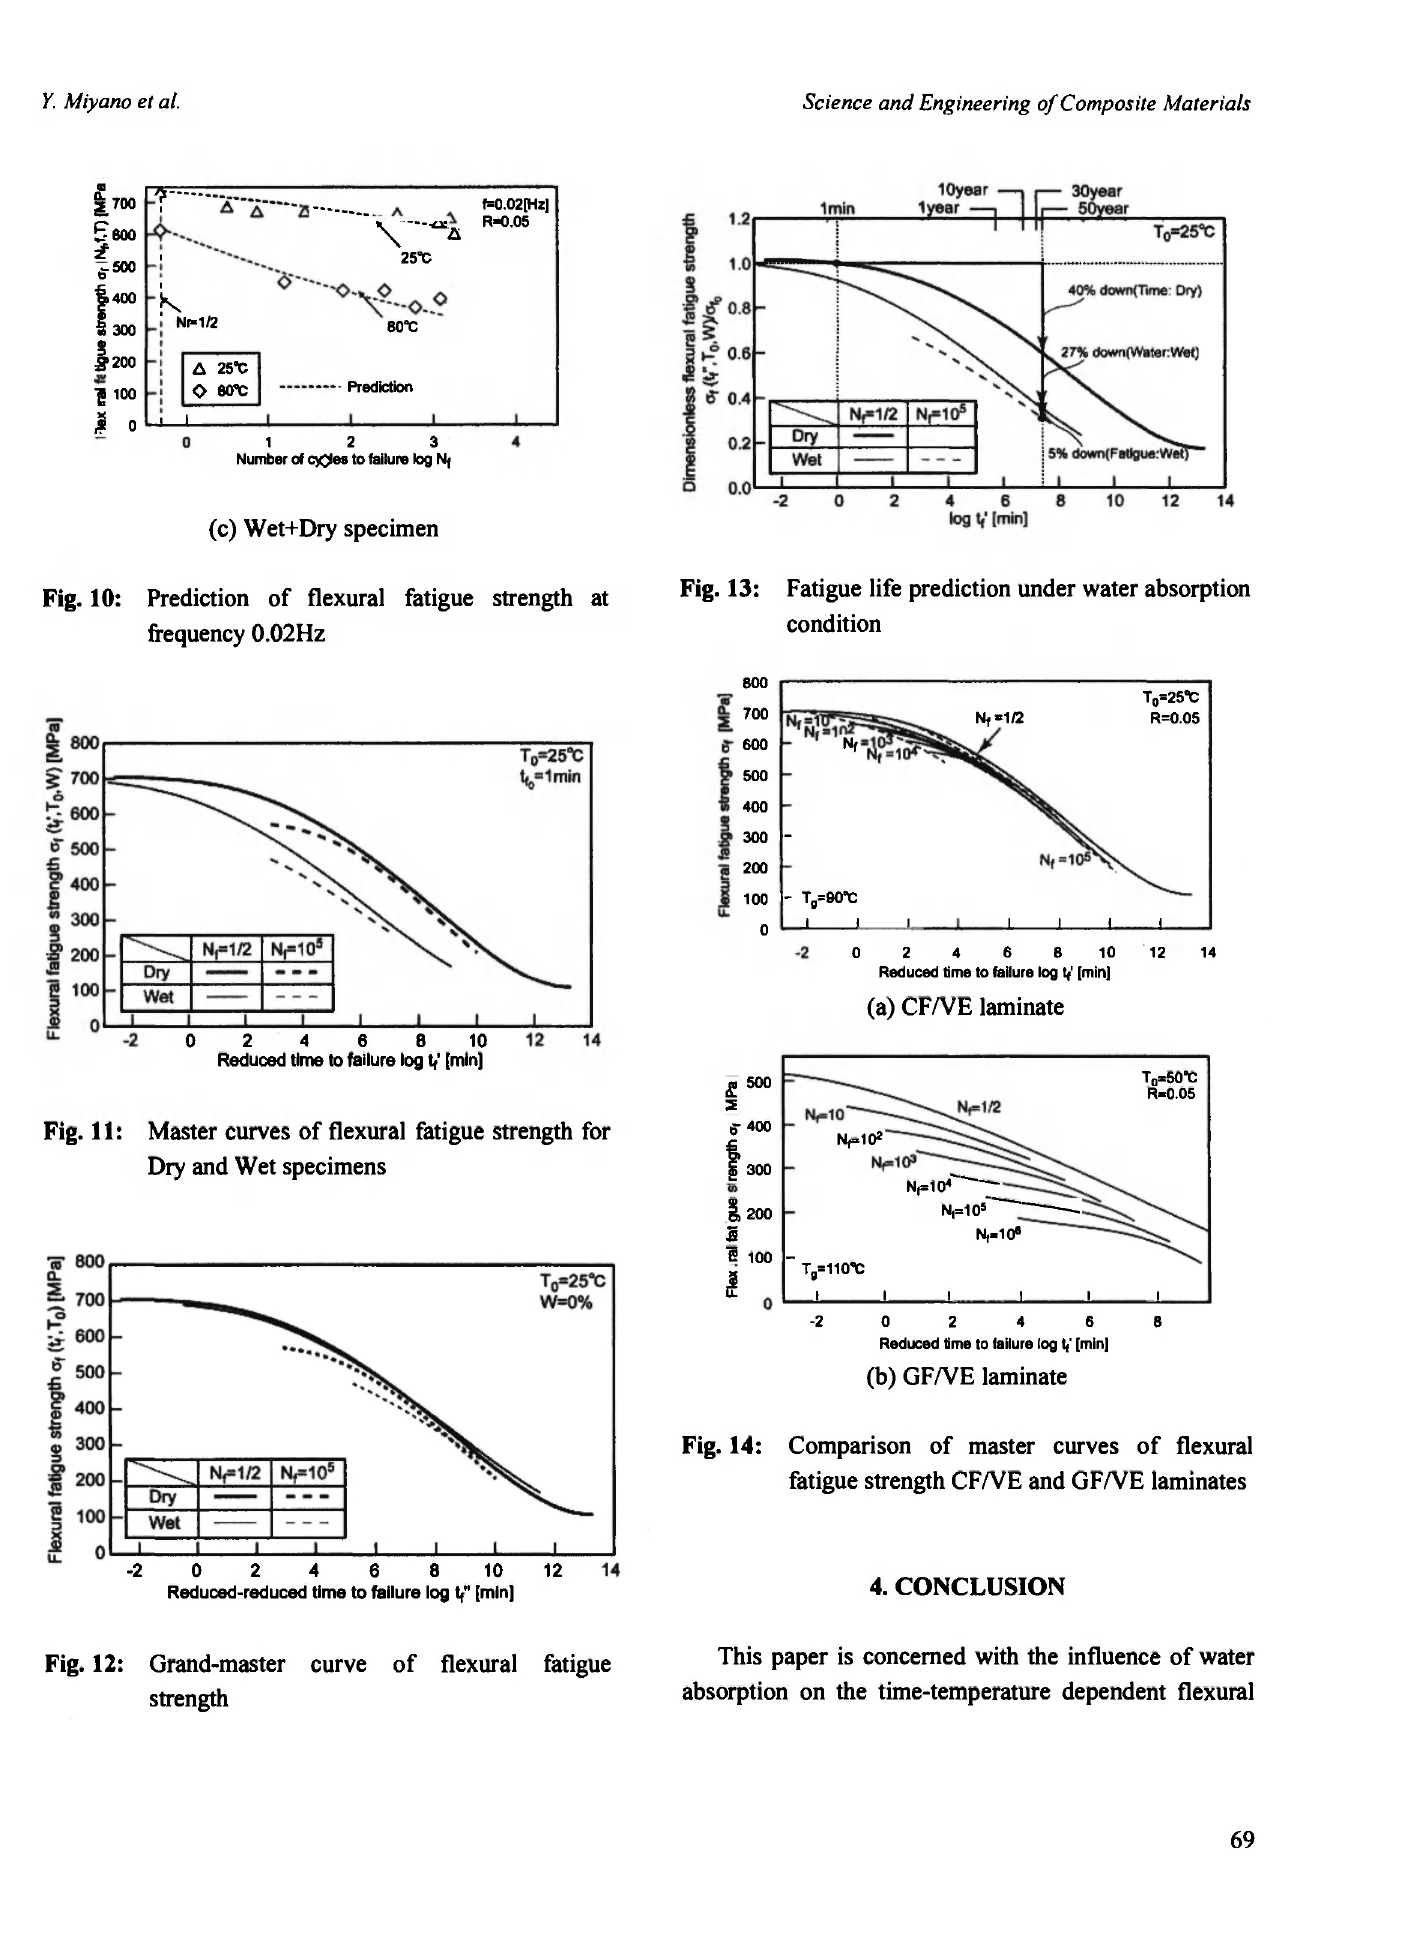
Grand-master curve of flexural fatigue strength